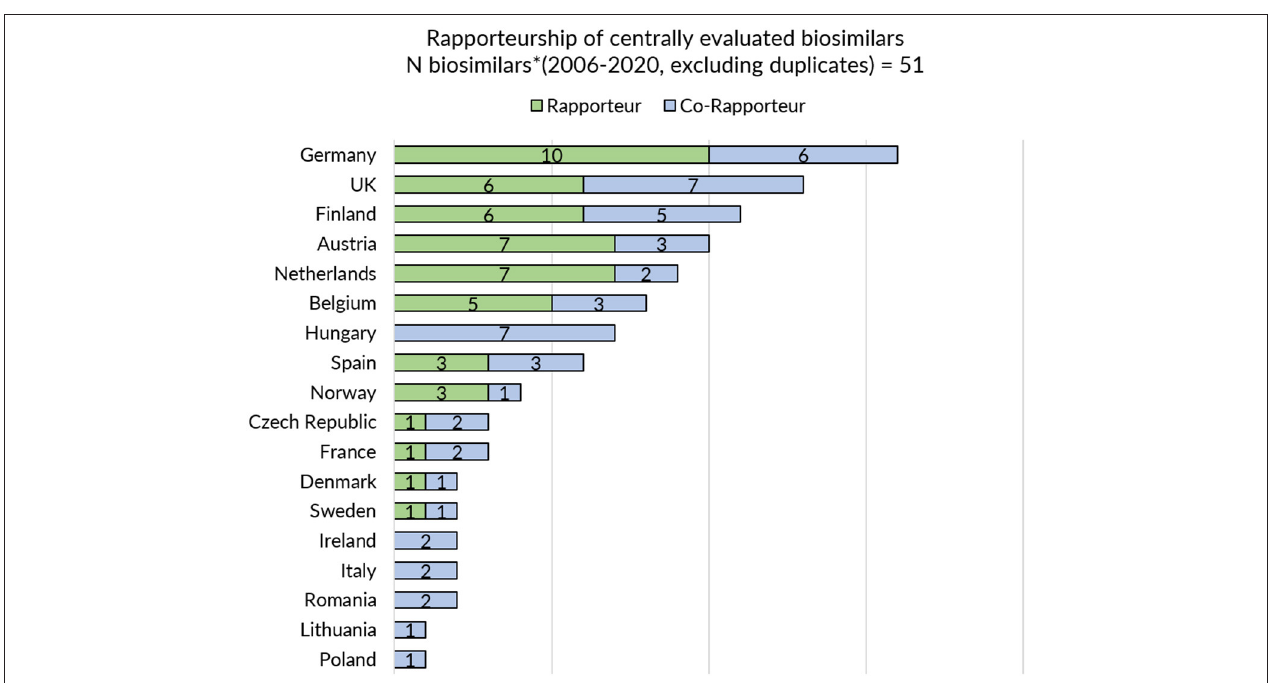
FIGURE 1 | Rapporteurship of centrally evaluated biosimilars. *Biosimilars that received marketing authorization or received a position opinion and were pending EC decision between 2006 and 2020 were considered. Products that were withdrawn post-authorization were excluded. Duplicates were excluded.